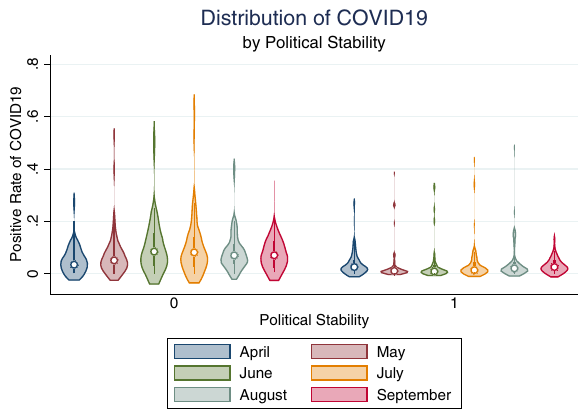
Fig. 12 Distribution of the COVID-19 positive rate by political